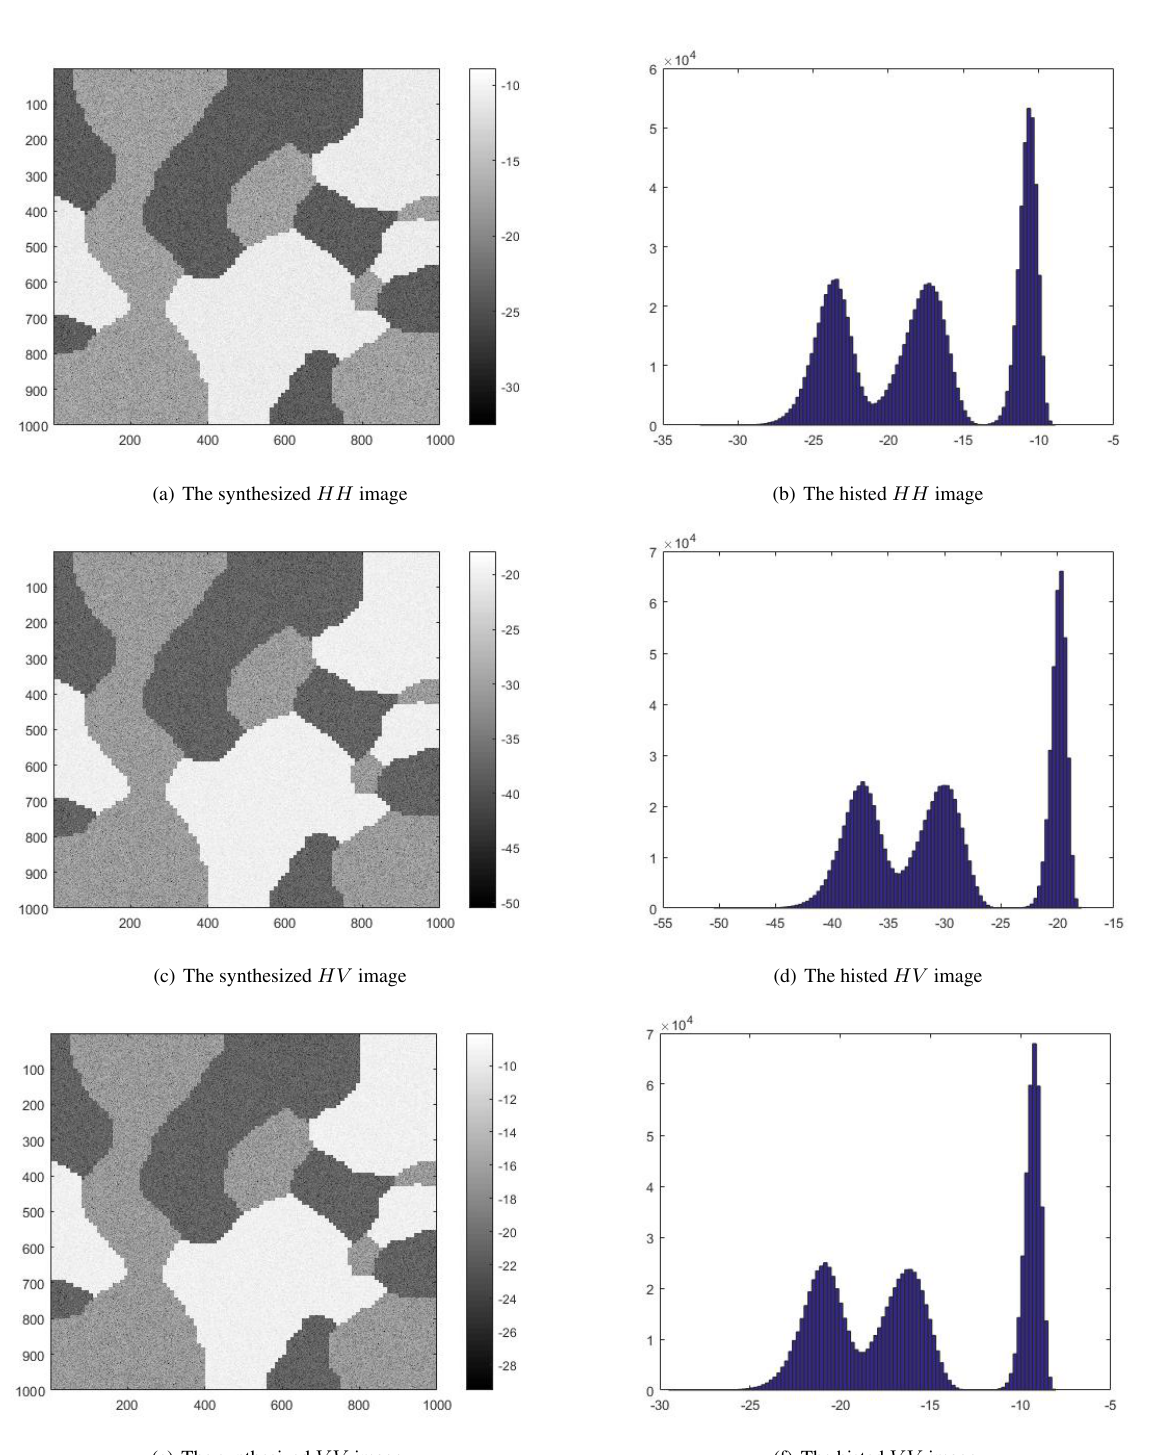
Figure 2. The synthesized SAR images ( HH , HV , V V ) using